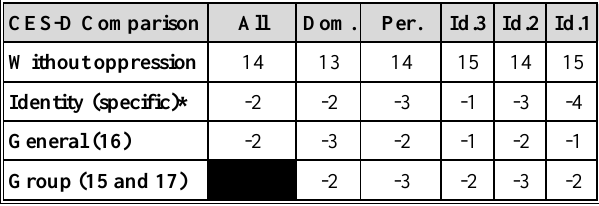
Table 8 : Data indicating better CES-D results without oppression CES-D Comparison